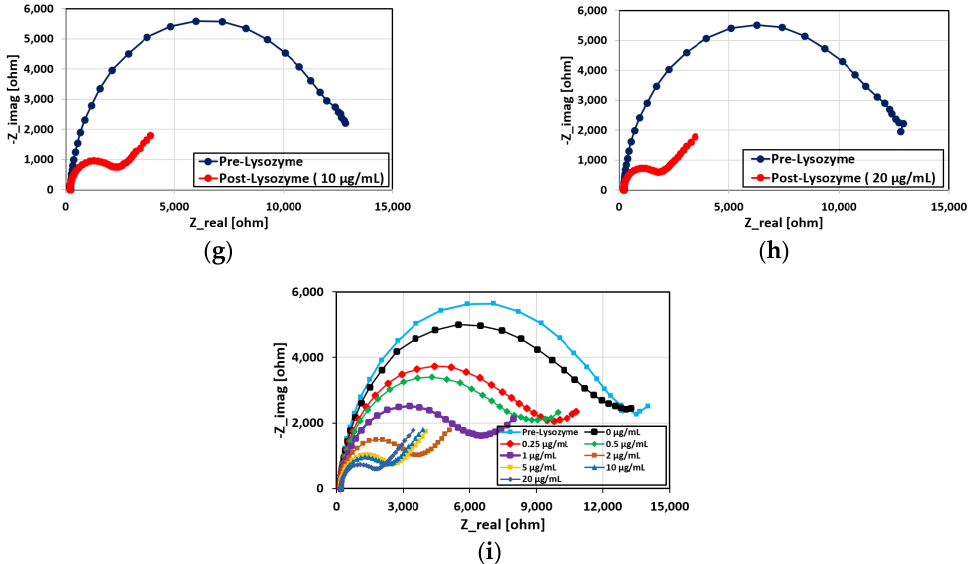
Figure 8. ( a )–( h ) Pre- and post-lysozyme Nyquist curves for different concentrations of lysozyme (0, 0.25, 0.5, 1, 2, 5, 10, 20 µg/mL, respectively) in 50 mM PBS as well as ( i ) post-lysozyme Nyquist curves for all the lysozyme concentrations.